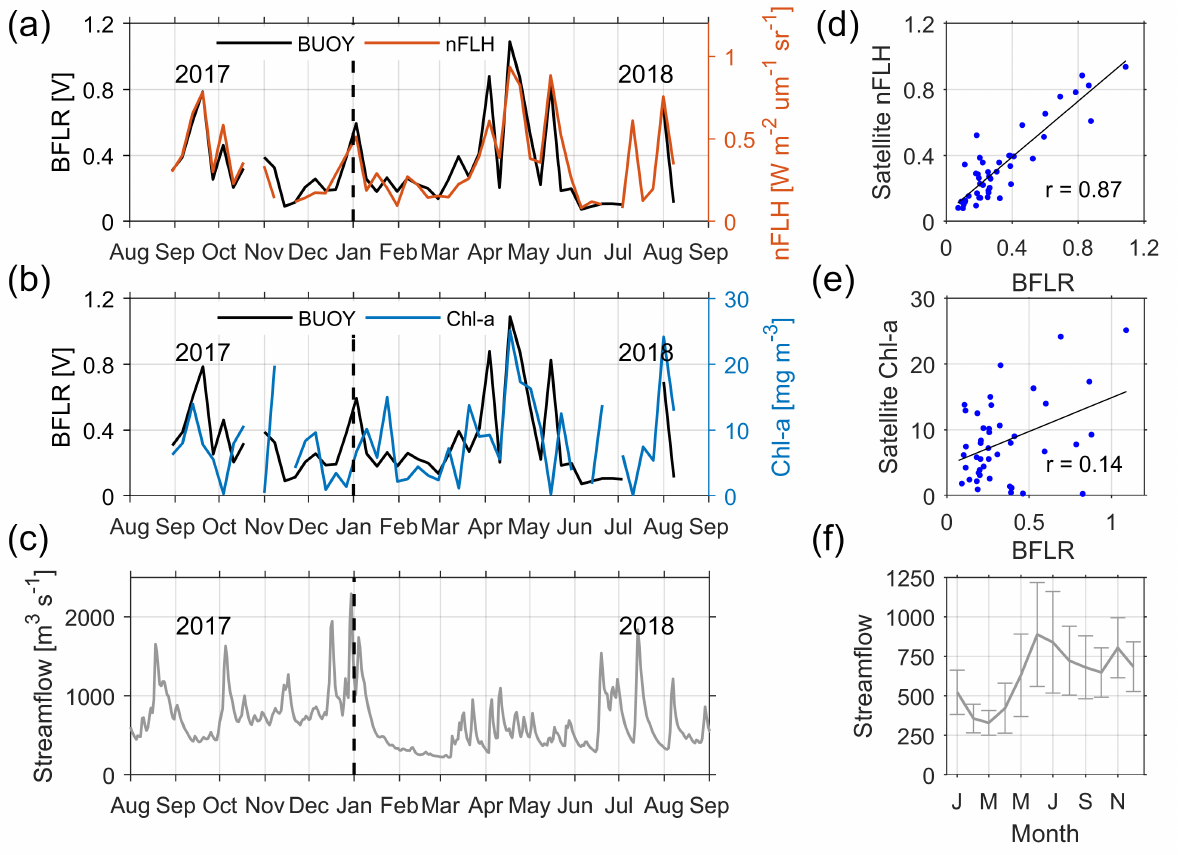
Figure 7. Comparison between near-surface (1 m) In situ fluorescence (7-day averages) and ( a , d ) nFLH and ( b , e ) Chl-a. r-values correspond to linear correlation coefficients. Puelo river discharge and its annual cycle is presented in ( c , f ), respectively. For reference of the buoy location, see Figure